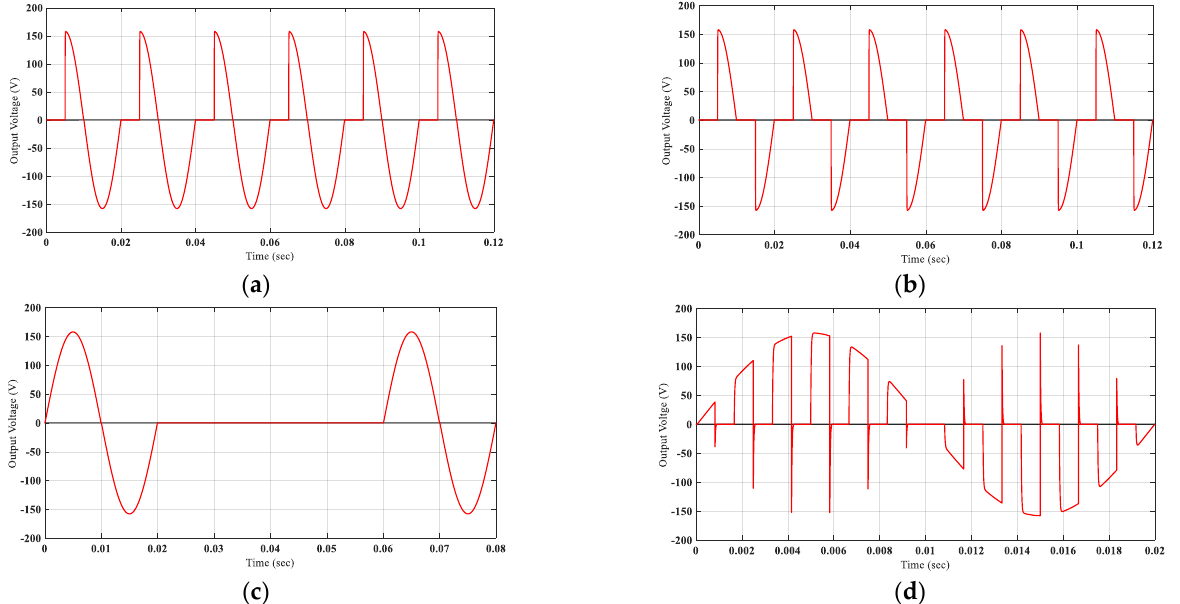
Figure 14. Output voltage control through ( a ) phase angle half-wave control; ( b ) phase angle full-wave control; ( c ) number of on-off cycles control; ( d ) PWM control.